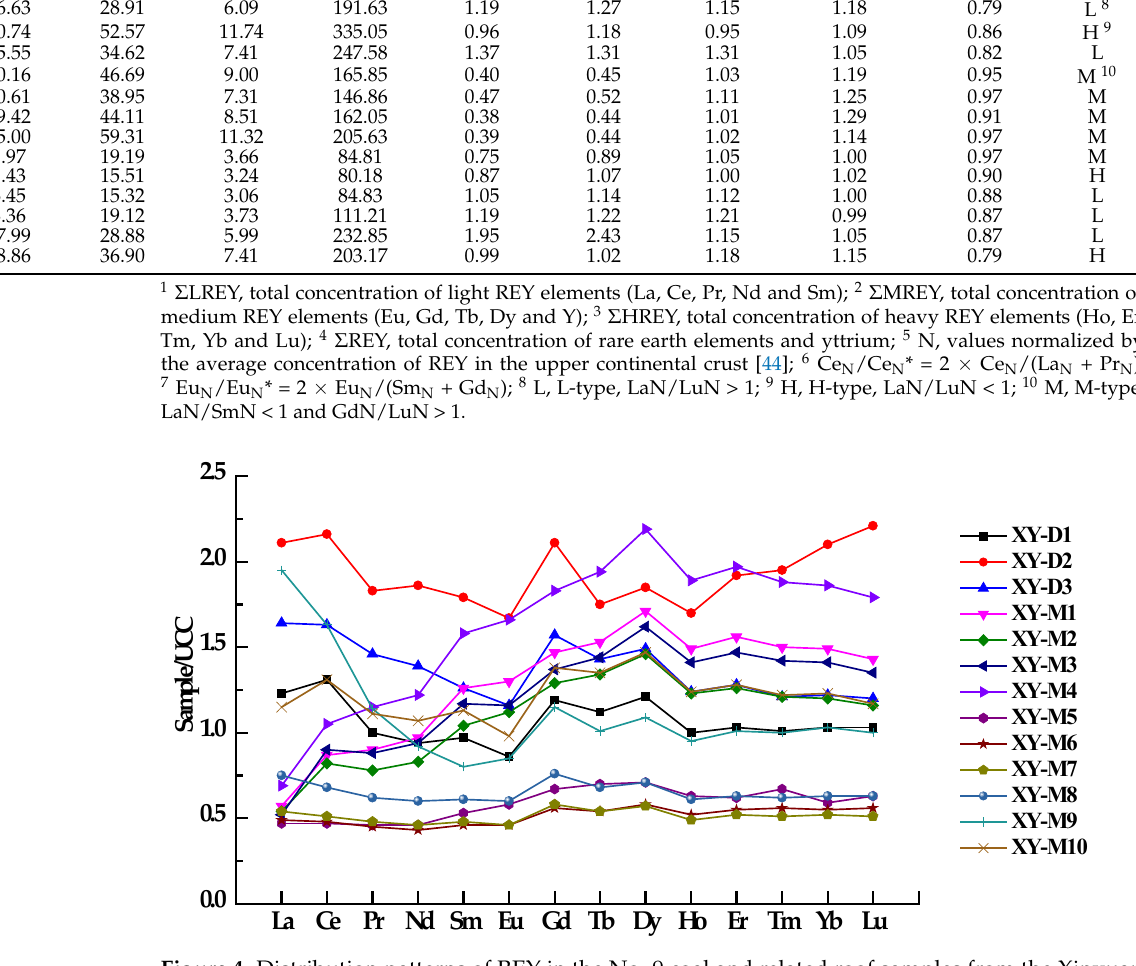
Figure 4. Distribution patterns of REY in the No. 9 coal and related roof samples from the Xinyuan mine; values are normalized by the average concentration of REY in upper continental crust